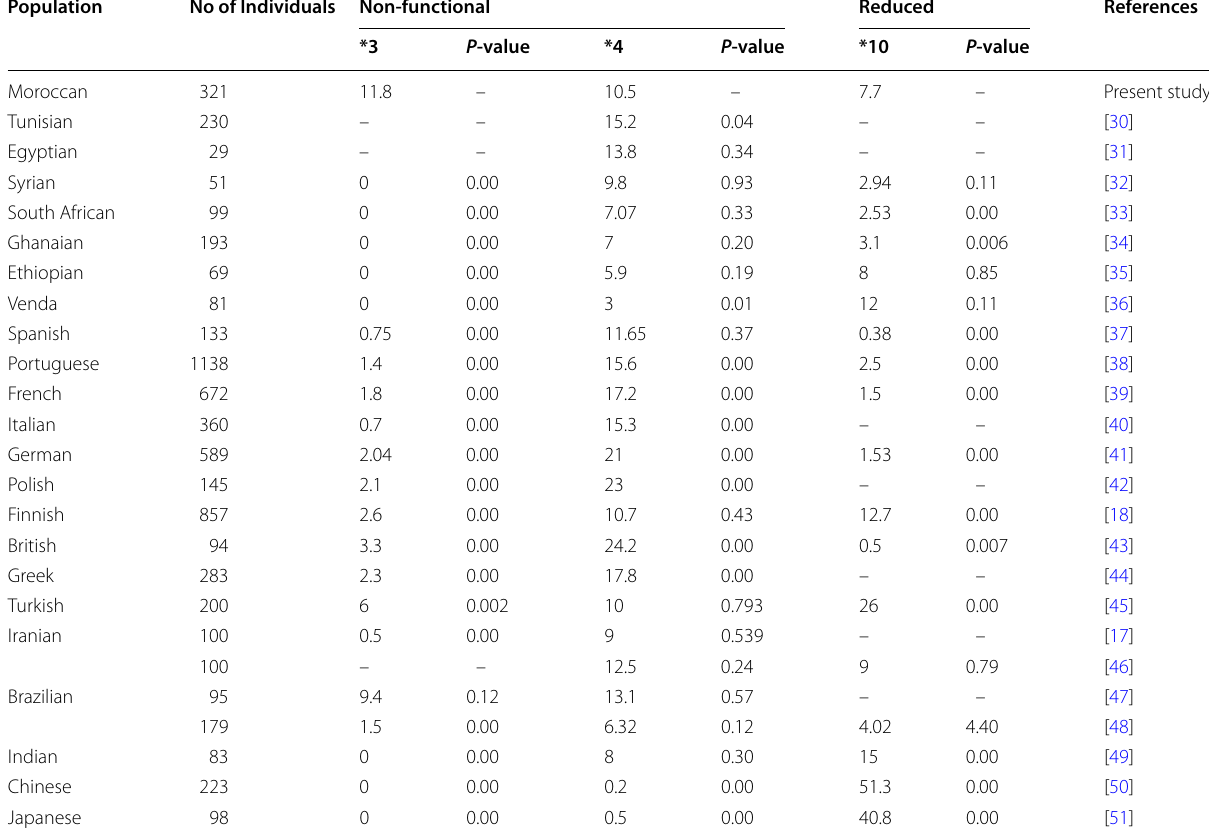
Table 5 Distribution of CYP2D6 allele frequencies in the Moroccan population compared to other worldwide populations Population No of Individuals Non-functional Reduced